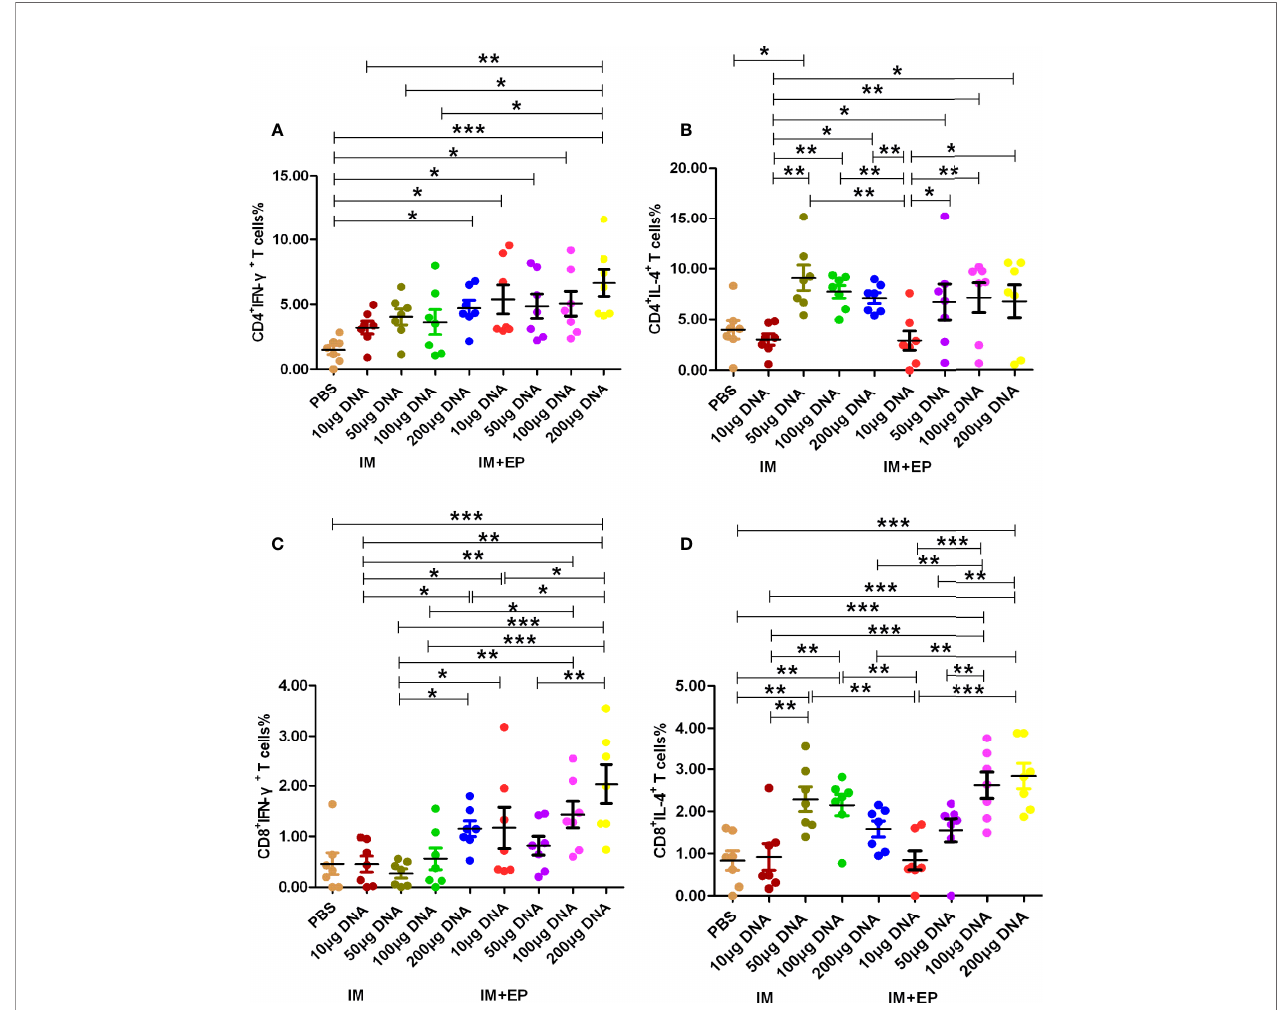
FIGURE 2 | Frequencies of CD4 + and CD8 + T cell subsets in whole blood were assessed by fl ow cytometry. At 17-18 days after the third immunization, the data are expressed as the mean% ± standard deviation (n = 7) from 7 mice in each group. (A) CD4 + T cells expressing IFN- g (IFN- g -FITC); (B) CD4 + T cells expressing IL- 4 (IL-4-PE); (C) CD8 + T cells expressing IFN- g (IFN- g -FITC); (D) CD8 + T cells expressing IL-4 (IL-4-PE). IM, intramuscular injection; EP, electroporation. * P <0.05, ** P < 0.01, ***P <